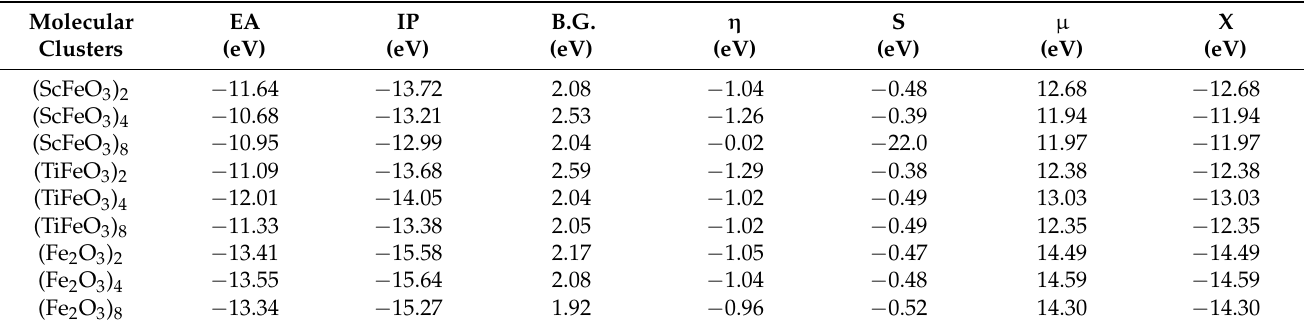
Table 2. Calculated values of HOMO, LUMO, HOMO-LUMO gap, electronegativity ( χ ), hardness ( η ),